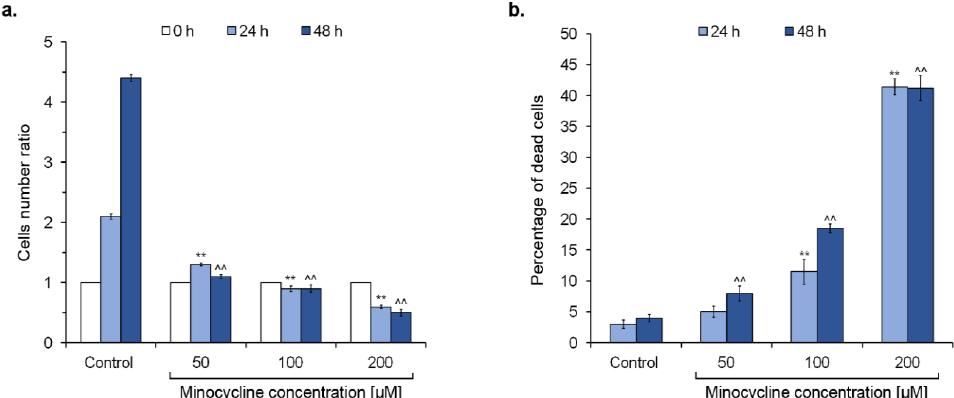
Figure 2. Minocycline inhibits the growth of human melanoma cells and increases the percentage of dead cells after 24 h and 48 h treatment. The cells were cultured with minocycline in a concentration of 50 µM, 100 µM, and 200 µM. The results are presented as the cell number ratio ( a ) and the percentage of dead cells in the tested population ( b ). ** p < 0.005 vs. control 24 h; ˆˆ p < 0.005 vs. control 48 h.